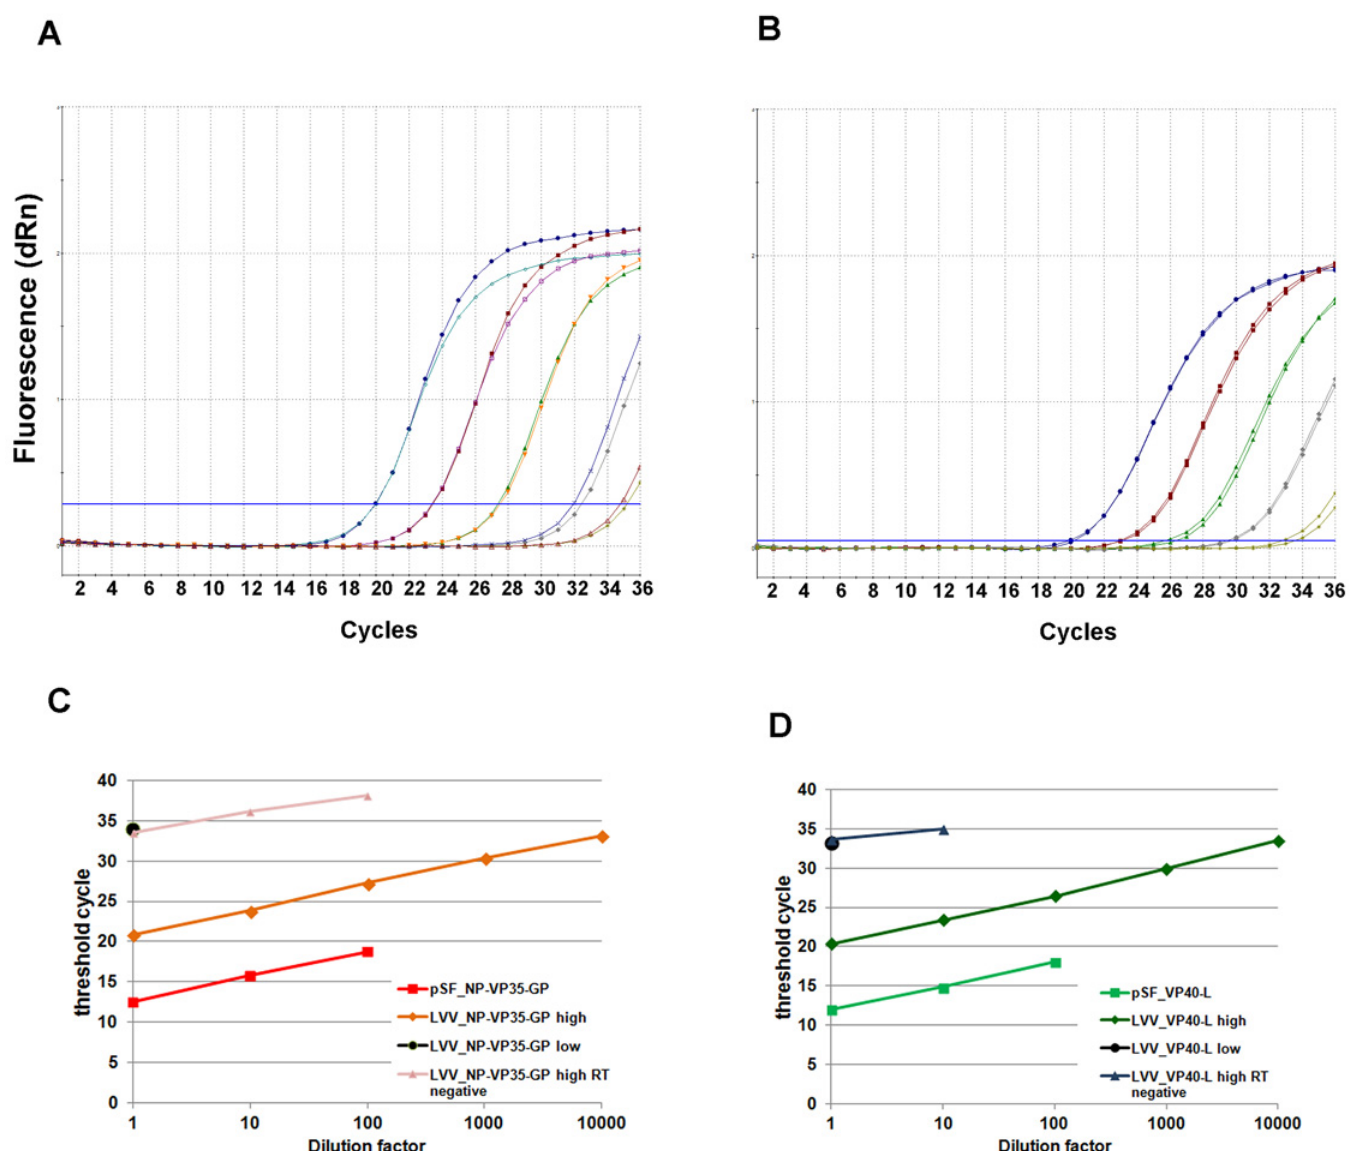
Fig 2. Performance of the HIV-EBOV RNA preparations in qRT-PCR. Representative amplification plot of two 10-fold serially diluted high titre LVV_NP-VP35-GP (A) and LVV_VP40-L (B) vials. Samples from two reconstituted vials per sample were run in duplicate and the mean values of the duplicates plotted as threshold cycle against fluorescence. The dilutions of the high titre LVV_NP-VP35-GP (C) and LVV_VP40-L (D) were also plotted against the dilution factor. Efficiencies of the reaction were calculated based on the slope of the regression line as 102% for np -target qRT-PCR and 110% for I -target qRT-PCR. The same samples, run without the reverse transcriptase reaction (RT negative), were detectable up to 10 − 2 dilution for LVV_NP-VP35-GP and 10 − 1 for LVV_VP40-L. Three 10-fold dilutions of the plasmids pSF-lenti-NP-VP35-GP and pSF-lenti-VP40-L were run in parallel and the values were the same between RT positive and RT negative